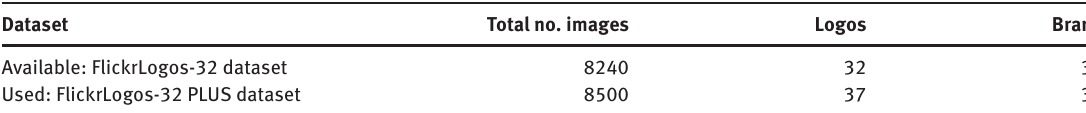
Table 1: Details of Logo Dataset Used in the Experimentation.